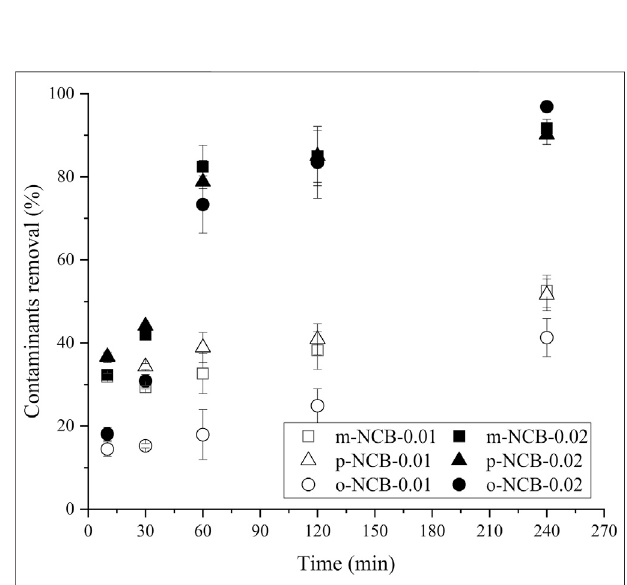
FIGURE 3 | NCB degradation by different amount of nZVI/BC and PS. The Fe/C ratio1:1, Fe/PS molar ratio 1:1, the initial NCB isomer concentration 10 mg L − 1 , and the reaction time 1 h.